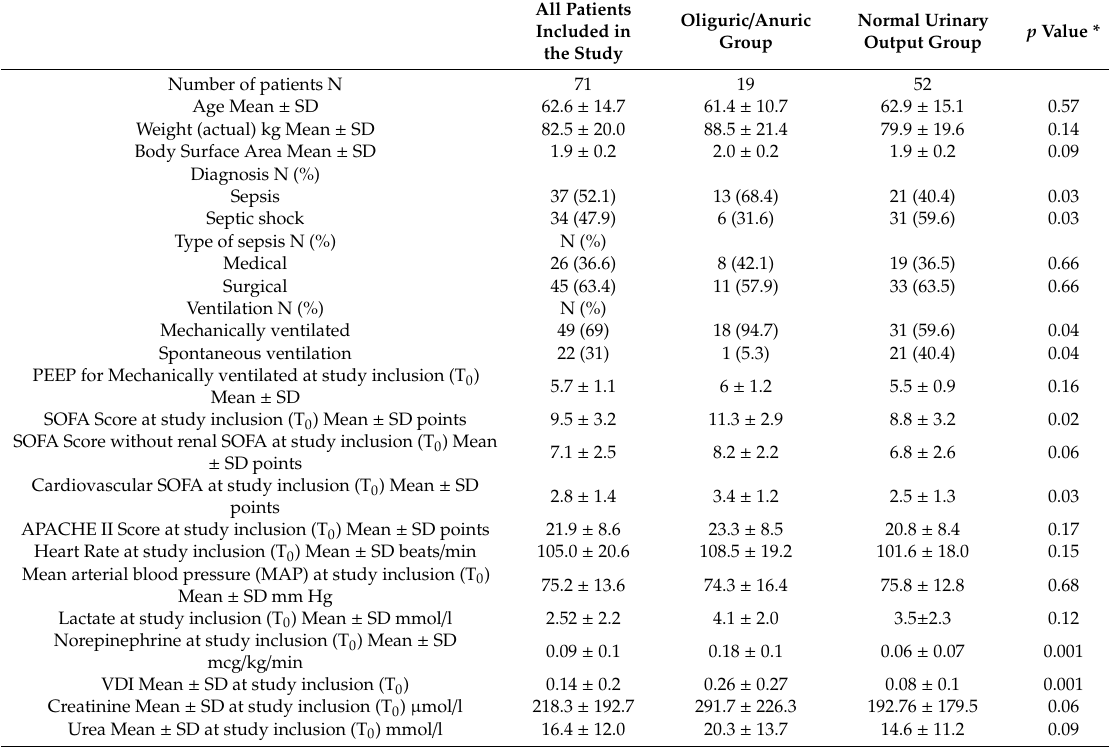
Table 1. Clinical and demographic characteristics of the patients included in the study.